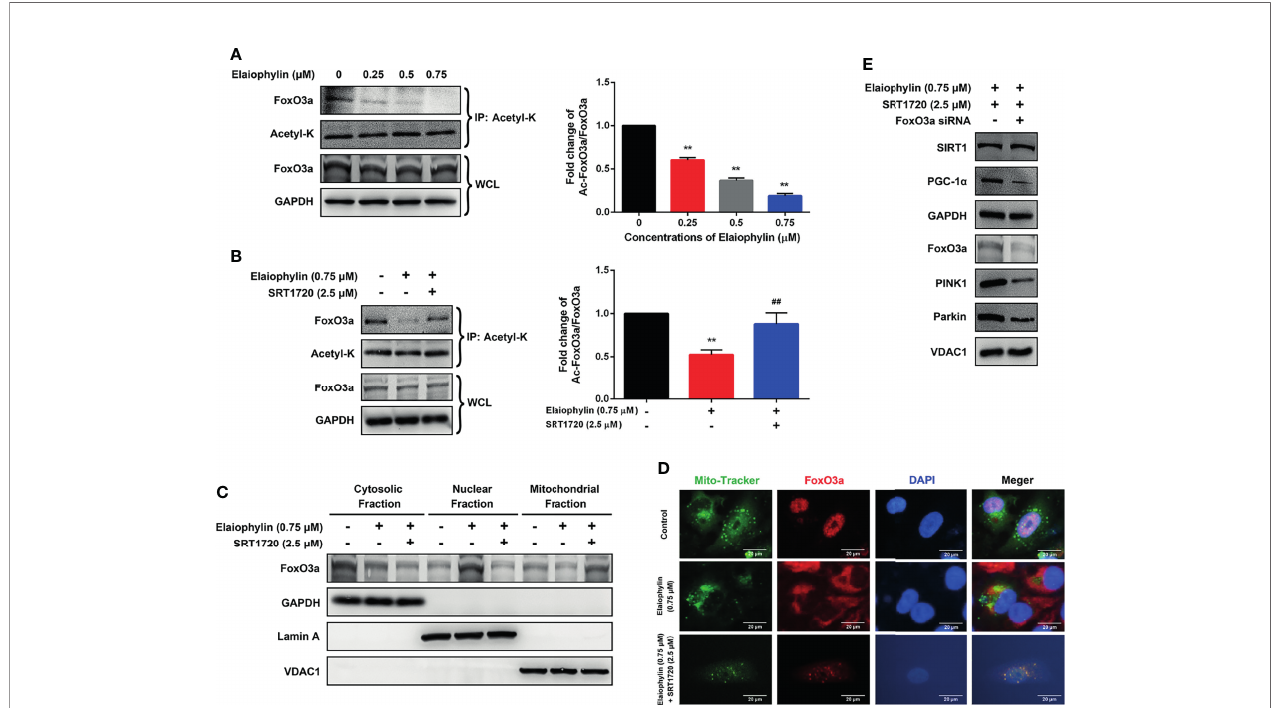
FIGURE 5 | Elaiophylin modulates SIRT1 in C918 cells by manipulating FoxO3a deacetylation and mitochondrial localization. (A, B) After treatment with indicated drugs, cells were divided into two groups. A portion of lysate was immunoprecipitated with anti-Acetyl-K antibody and the rest was directly subjected to immunoblotting. The representative images were shown on the left and the densitometry analysis of protein expression was shown on the right. (C) Cell lysate fractions (ie. cytosolic, nuclear, and mitochondrial fractions) were prepared and subjected to immunoblotting analysis. GAPDH is the cytosolic marker; LaminA is applied as the nuclear marker; and VDAC1 is adopted as the mitochondrial marker. (D) Colocalization of mitochondria with FoxO3a by immuno fl uorescence (E) The expression of typical proteins related to mitophagy. Western blotting was performed to analyze the representative proteins in mitophagy. GAPDH and VDAC1 were used as loading controls for cytoplasm and mitochondria, respectively. Data was expressed as mean ± SD of three experiments. ** p <0.01 vs. control, ## p <0.01 vs. Elaiophylin